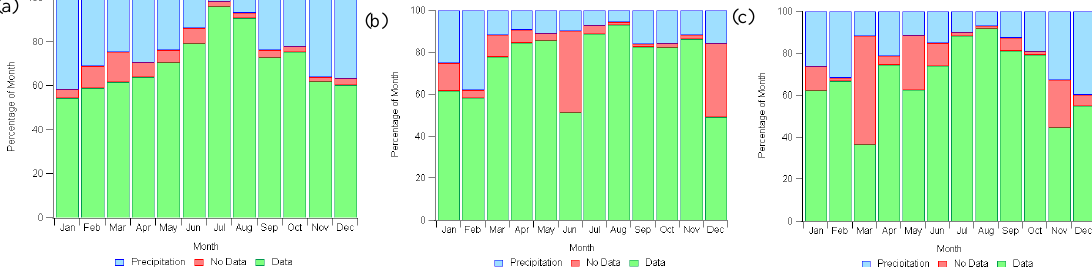
Fig. 5. Yearly plots showing the percentage of time each month that the lidars collected data, precipitation occurred, or the system was down. The data are from 2010 for (a) CORALNet UBC, (b) CORALNet Egbert and (c) CORALNet Acadia.